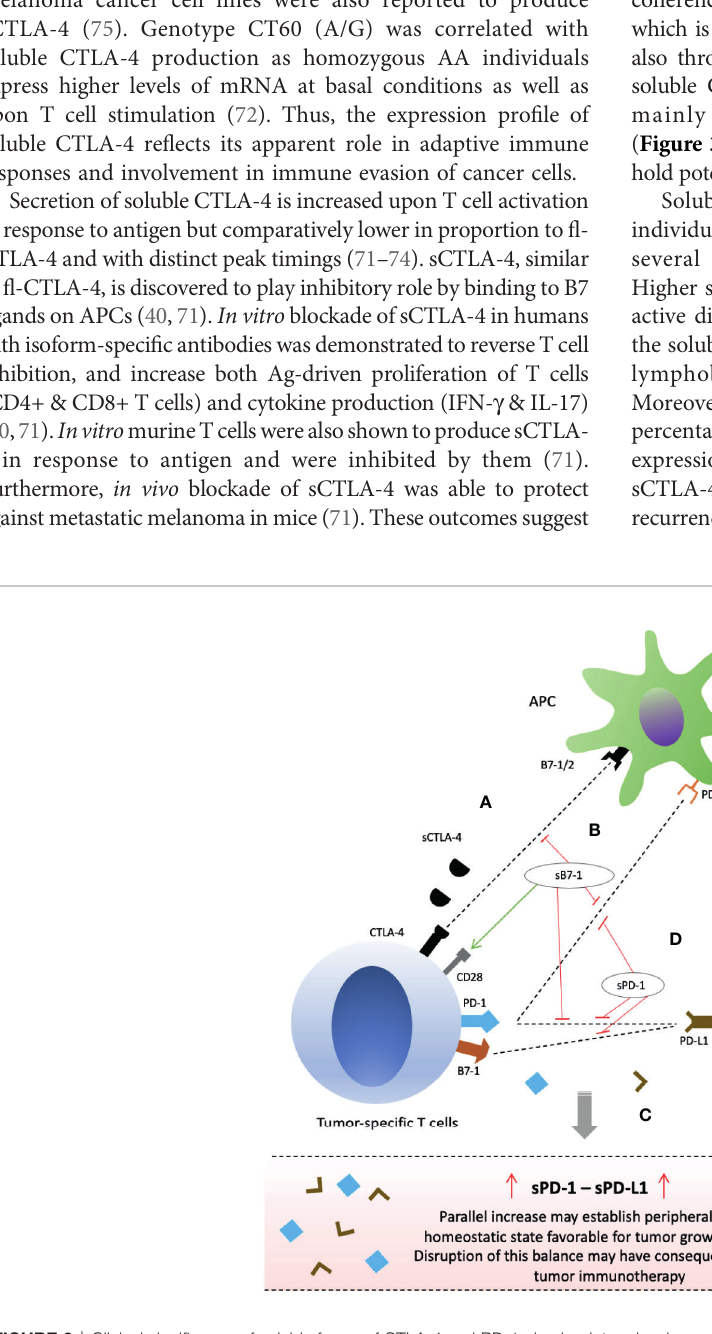
FIGURE 3 | Clinical signi fi cance of soluble forms of CTLA-4 and PD-1 checkpoint molecules and their potential for anti-cancer immunotherapy. (A) sCTLA-4 exert its inhibitory effects via CD28 antagonism. Blockade with anti-CTLA-4 monoclonal antibody or B7-1 upregulation/gene delivery of sB7-1 may enhance T cell immune responses. (B) Gene delivery of soluble B7 increase T cell activity not only through increased CD28 co-stimulation but also simultaneous inhibition of PD-1 and PD- L1 interactions. (C) Parallel secretion of sPD-1 and sPD-L1 by tumor-speci fi c T cells and tumor/peritumor tissue, respectively, maintain an inhibitory homeostatic microenvironment in tumor local milieu and peripheral circulation. (D) sPD-1 delivery in local milieu through gene therapy may enhance anti-cancer immunity by preventing mPD-1 from interactions with sPD-L1 and mPD-L1/2 present on tumor cells or APCs, and also blocking PD-L1 and B7-1 interactions. Abbreviations: CTLA-4; PD-1; sCTLA-4, PD-L1,